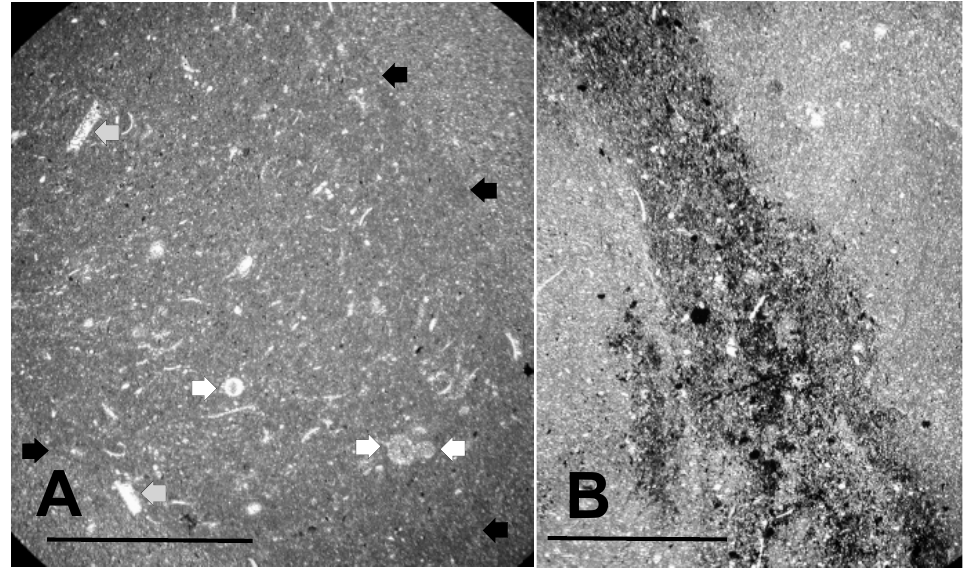
Figure 4. Texture of the Lower Tully Formation microfossil bed. ( A ) thin section (TYT-11) cut parallel to bedding showing burrow cross-section. The burrow appears as the slightly darker, more microcrystalline region in the center of the picture (periphery highlighted by black arrows). Small black masses of pyrite can be seen widely disseminated within the burrow. Also inside the burrow are a small number of circular objects (white arrows), and numerous sparry structures, some of which are shell fragments (gray arrows). Scale bar = 1 mm; ( B ) thin section (TYT-23) cut perpendicular to bedding showing a pyrite-rich burrow. Scale bar = 750 µm.